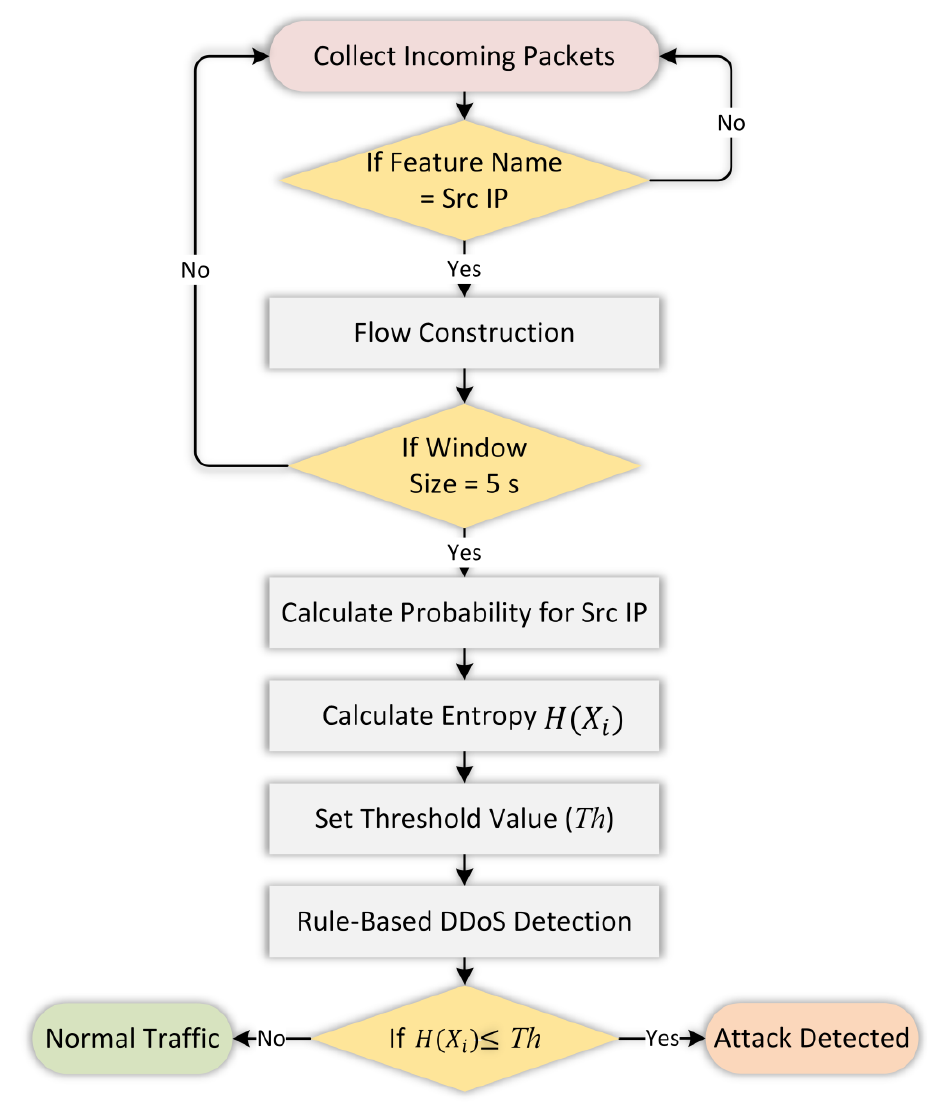
Figure 2. Detection approach process .